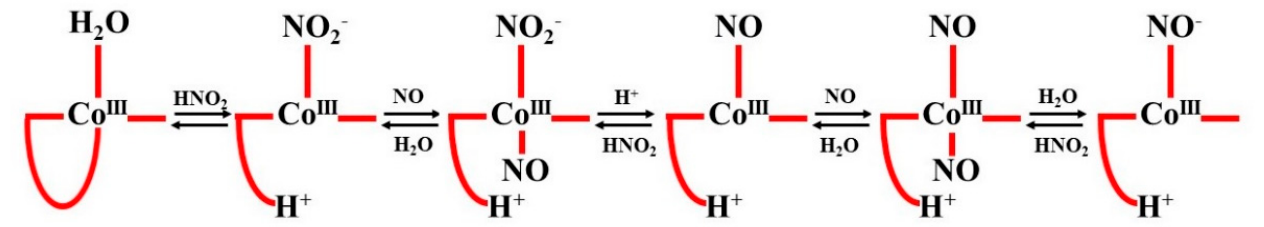
Figure 19. Reaction scheme for the reductive nitrosylation of Cbl(H 2 O) at low pH (according to [17]). The instability of the Co III -NO species, demonstrated previously for Co(III) por- phyrins, accounts for the practical inability of Cbl(H 2 O) to react directly with NO. Thus, the mechanism of reductive nitrosylation of Cbl(H 2 O) is significantly different from that of an analogous reaction involving Fe(III)